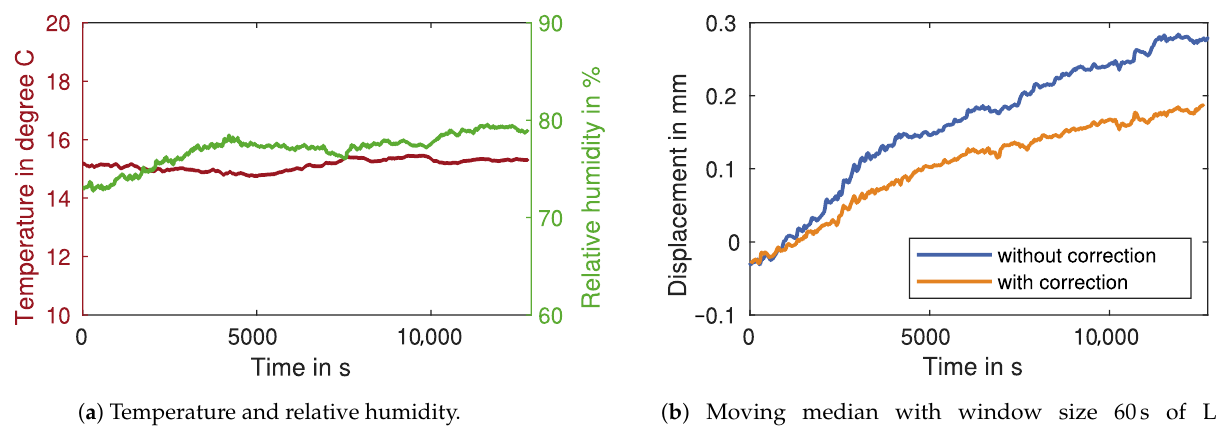
displacements with and without atmospheric correction. Figure 12. Atmospheric correction with measured atmospheric parameters.